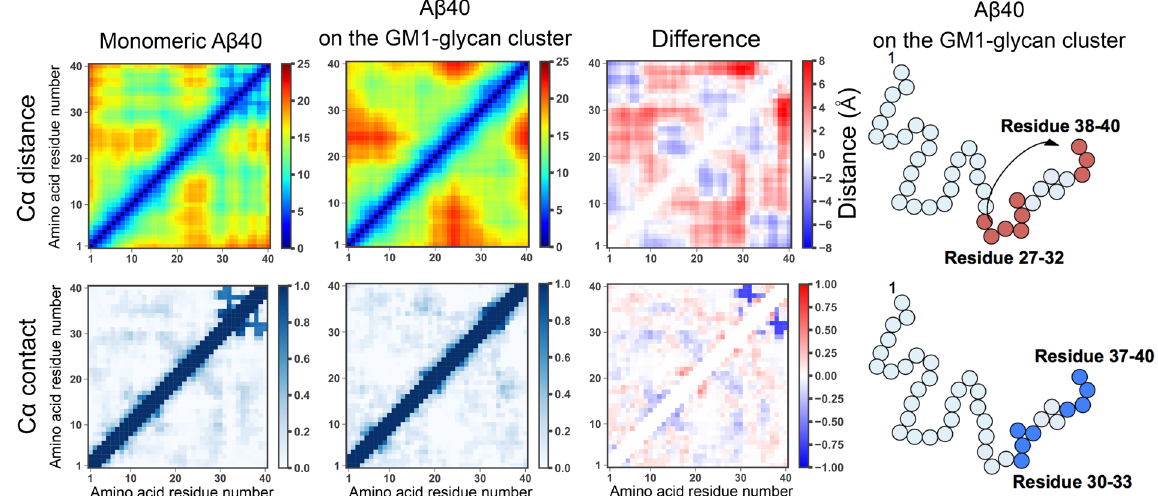
Figure 6. Matrices of average C α distance and contact in each residue pair in the cases of A β 40 on the GM1- glycan cluster and monomeric A β 40, and these matrix differences.